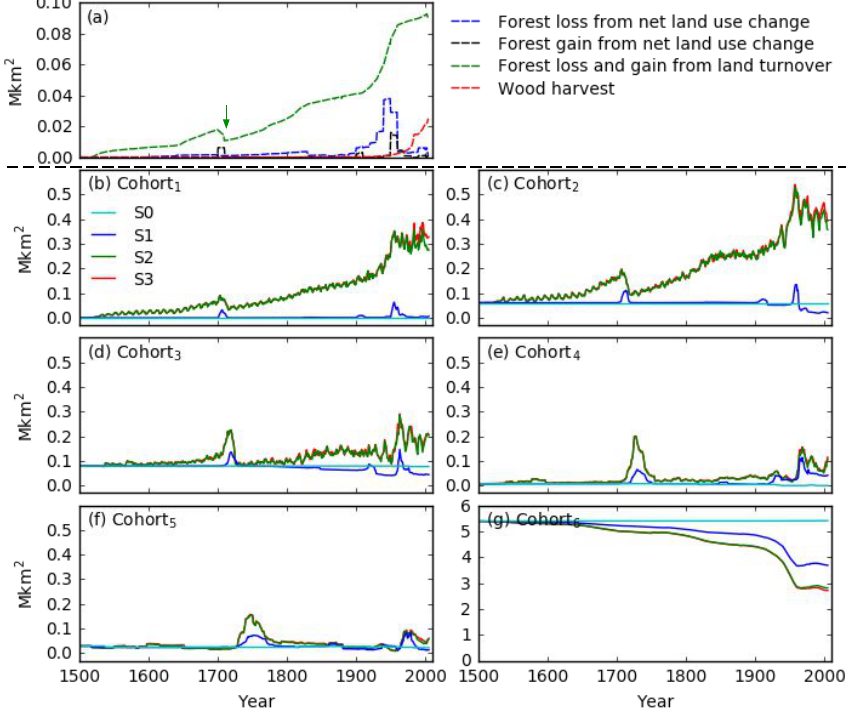
Figure 9. Areas subject to historical land use change and the resulting modelled temporal changes in areas of different forest cohorts in southern Africa. (a) Areas subjected to historical land use change in which forests are involved. Data are from the LUH1 reconstruction (Hurtt et al., 2011) after adaption for ORCHIDEE-MICT. Three types of LUC activities are shown and their effects elucidated by factorial simulations (Table 4). These are forest loss (blue dashed line) and gain (black dashed line) resulting from net land use change, forest involved in land turnover (both loss and gain in equal amount, green dashed line), and forest area subjected to wood harvest (red dashed line). (b) – (h) Areas of forest cohorts (Cohort 1 : the youngest; Cohort 6 : the oldest) for four factorial simulations (Table 4) in which no land use change occurs in S0, and the three LUC types are added in a factorial set-up in S1 (net land use change, blue solid line), S2 (net land use change + land turnover, green solid line), and S3 (net land use change + land turnover + wood harvest, red solid line). Note y scale values in (a) and (h) differ from